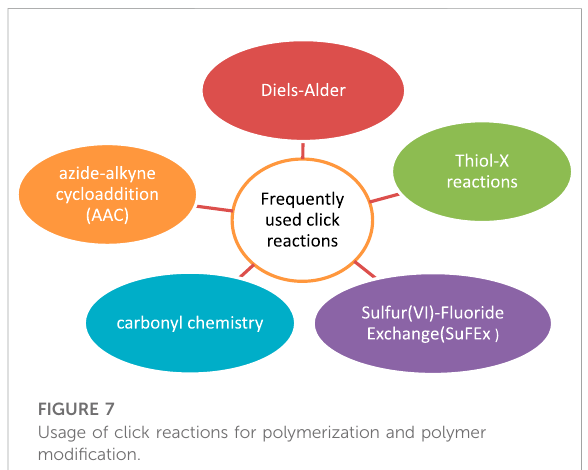
FIGURE 7 Usage of click reactions for polymerization and polymer modi fi